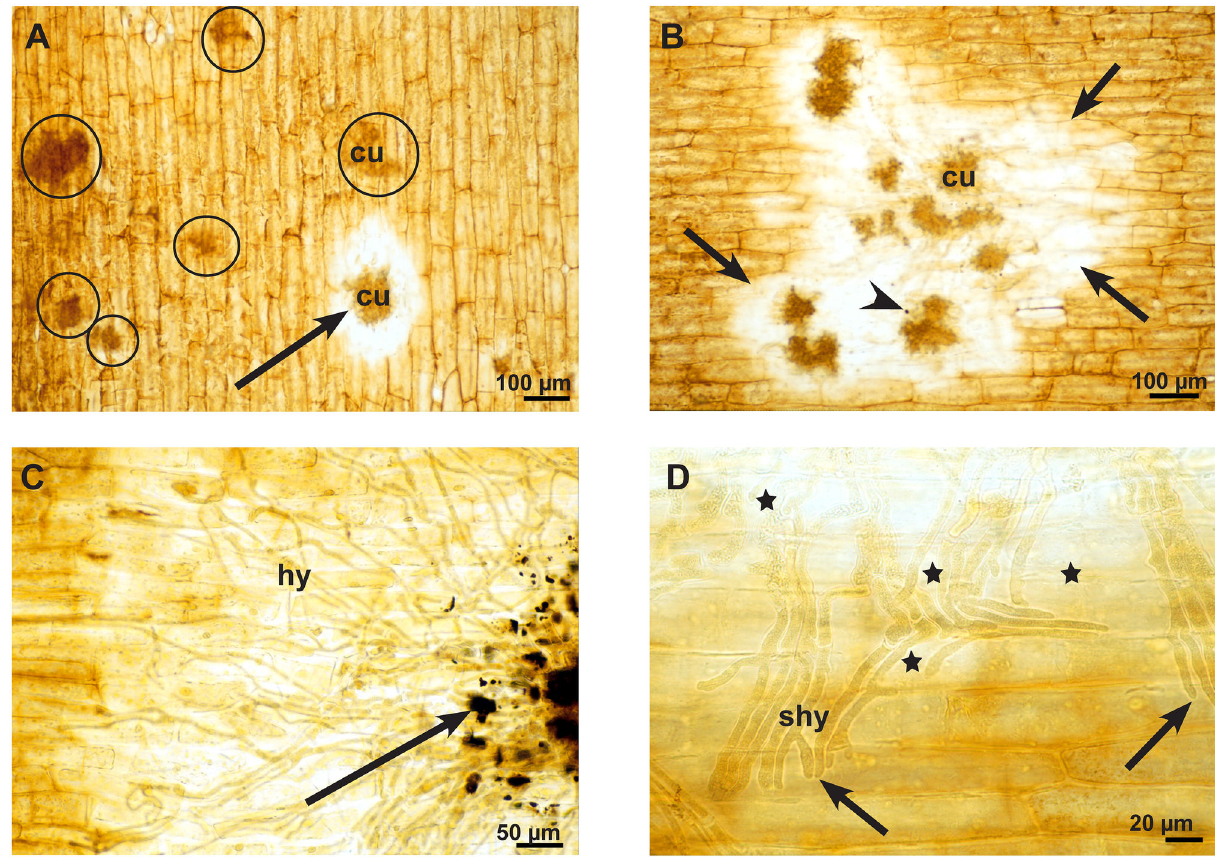
Figure 7. Secretion of oxalic acid in the infection process of S. sclerotiorum . Light micrographs of the early, advanced, and late stages of infection after histochemical staining for calcium oxalate of fresh epidermal strips that resulted in a yellow-brownish colour of tissue and a brown-black colour of the compact oxalate crystals. A : At the early infections stage (12-24 hpi) the epidermal layer around one infections cushion (cu) is bleached (arrow), while most of the infection cushions (circles) do not show any influence on the epidermal layer. B : In the advanced stage (36-48 hpi) there is bleaching of the epidermal layer (arrows) around all infection cushions (cu) and only a single dark stained particle of oxalate was visible (arrowhead). C : At the late stage (72 hpi) there is not only bleaching, but calcium oxalate crystals accumulate around the infection cushions (arrow). D : Detail of a late stage at the infection front. The bleaching effect (stars) did not become visible at the hyphal tips (arrows), but along the older parts of the subcuticular hypha